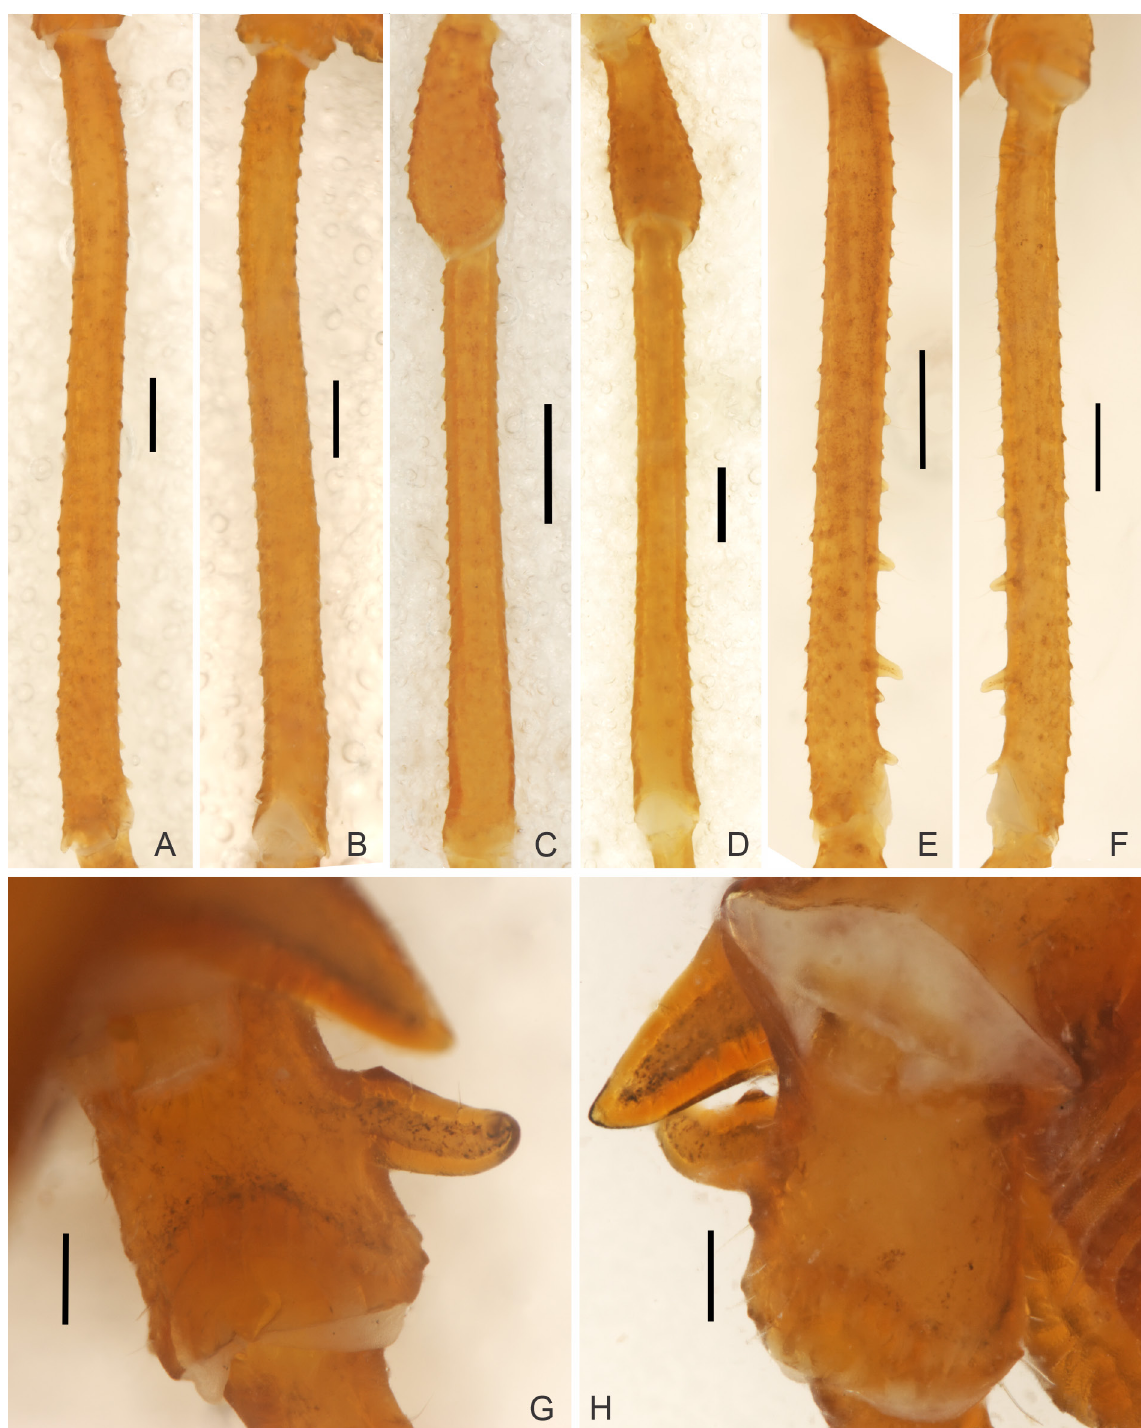
Fig. 2. Eusarcus capixaba sp. nov., ♂, holotype (ISLA 12966). A – B . Femur IV, dorsal and ventral view, respectively. C – D . Patella and tibia IV, dorsal and ventral view, respectively. E – F . Femur III, dorsal and ventral view, respectively. G – H . Trochanter IV, dorsal and ventral view, respectively. Scale bars: A–F = 0.5 mm; G–H = 0.2